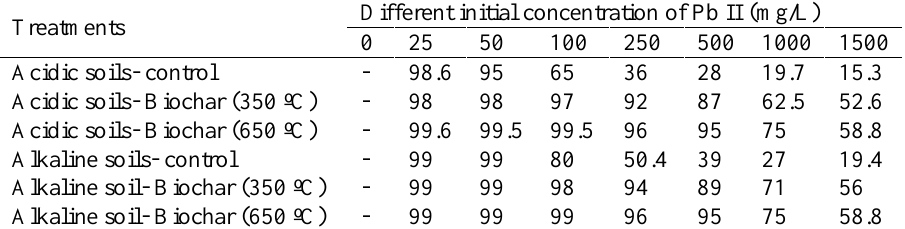
Table 7. The percentage of adsorption Pb (II) on two soils Treatments